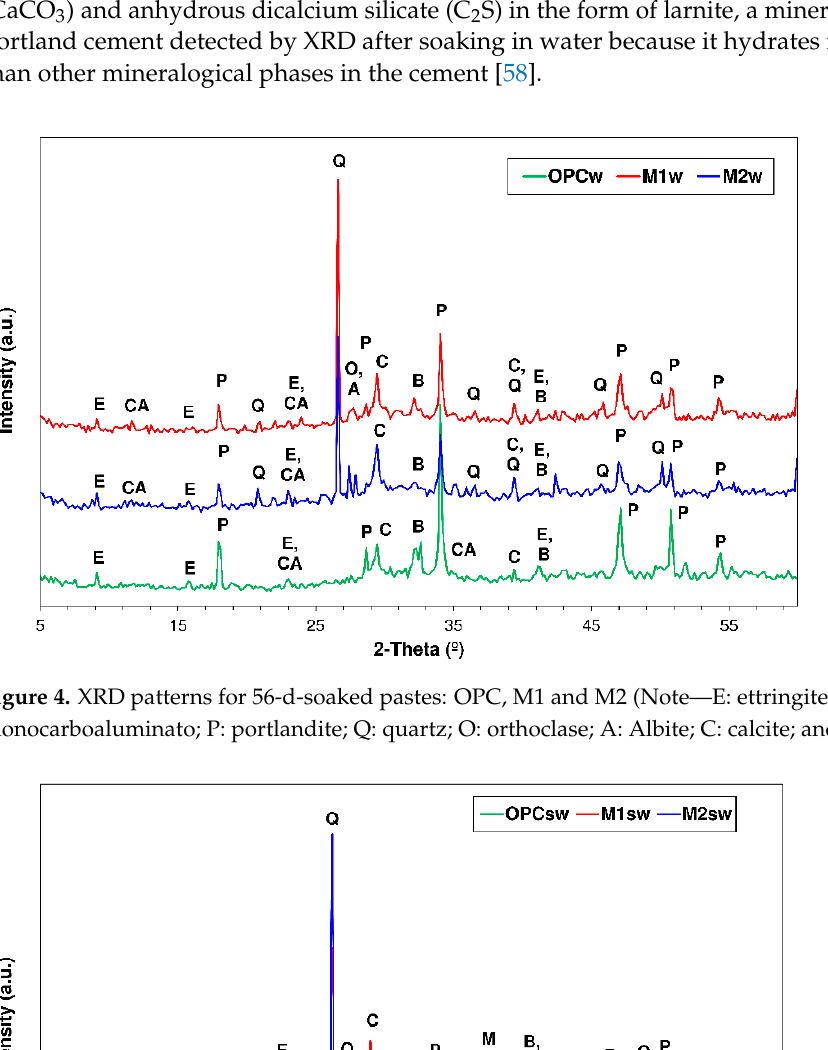
Figure 6. XRD patterns for 56-d OPC, M1 and M2 exposed to 0.5 M NaCl (Note—E: ettringite; F: Friedel’s salt; P: portlandite; Q: quartz; O: orthoclase; A: Albite; C: calcite; and B: belite). Specimen exposure to the action of Na 2 SO 4 (Figure 7) translated primarily into a rise in the intensity of the diffraction line for ettringite. The gypsum (Ca 2 SO 4 ⋅ 2H 2 O) formation identified with SEM/EDX (see Section 3.4), could not be corroborated via XRD because the respective diffraction line overlapped with the reflections for other phases present in the pastes, such as the monocarboaluminates (2 θ = 11.7°) and quartz (2 θ = 20.8°) [64].